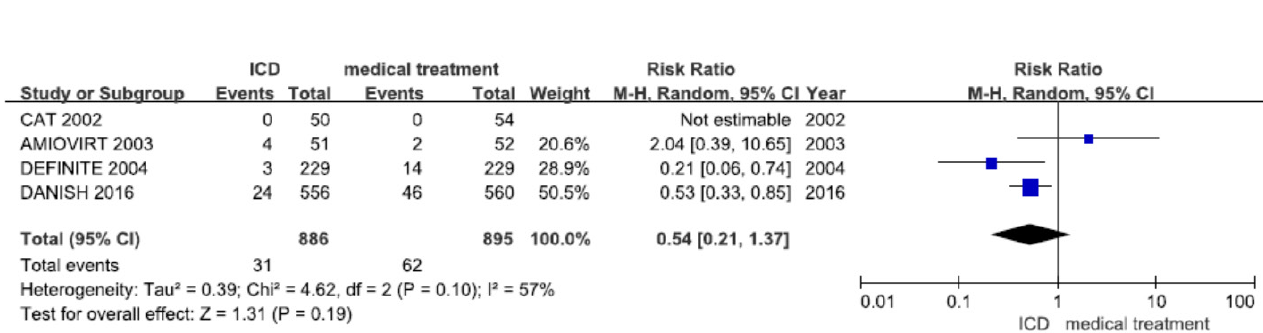
Fig. 4 - SCD among patients with non-ischemic heart disease randomized to ICD vs. medical treatment only in primary